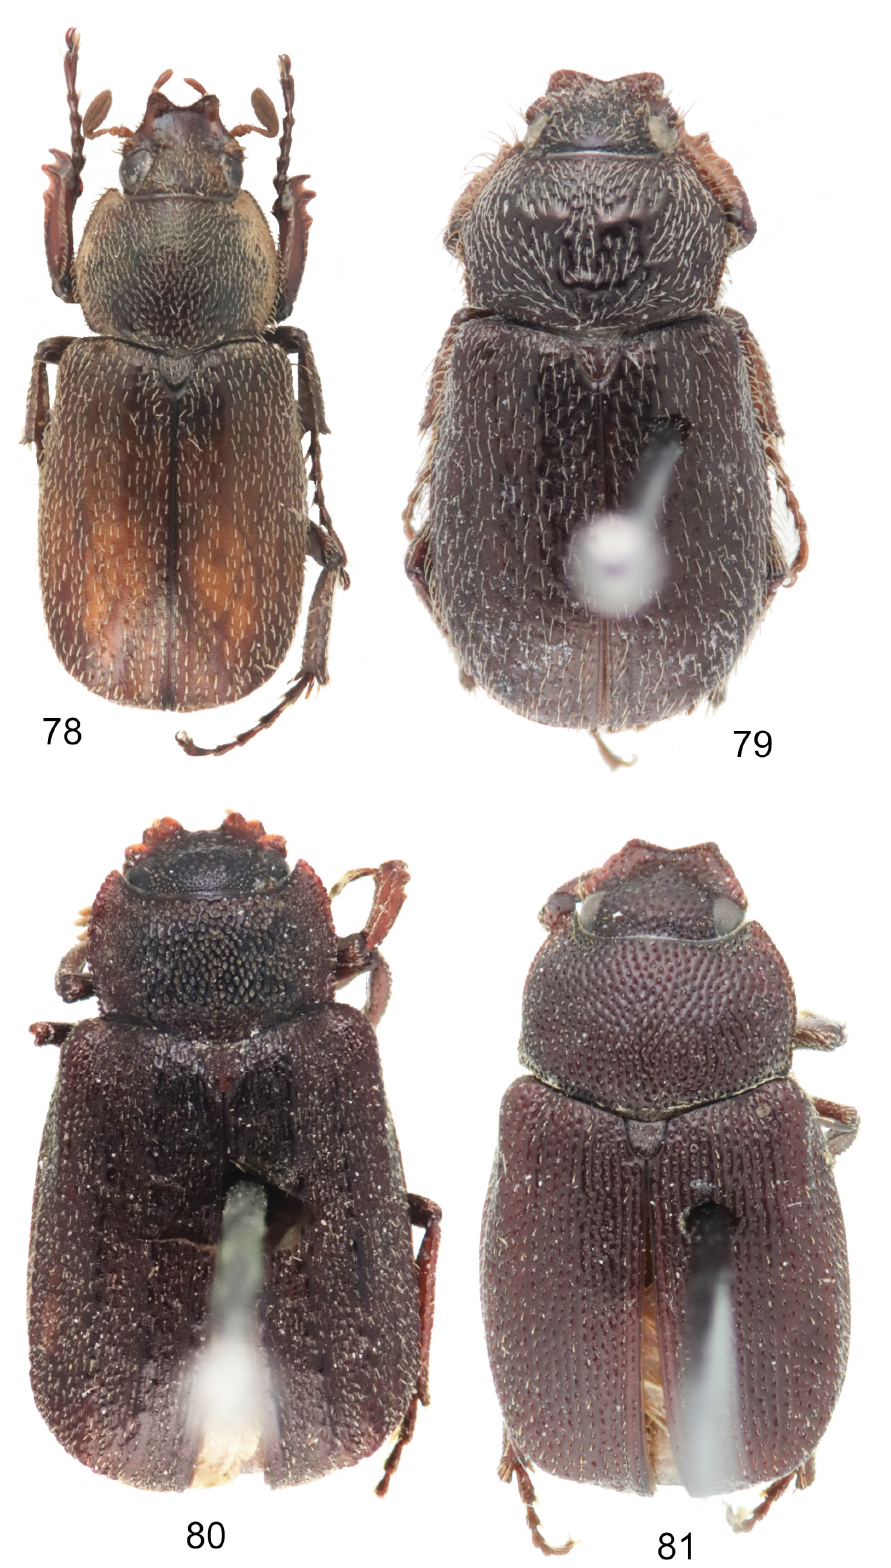
Figs 78–81. Papuan Maechidius Macleay, 1819, habitus, dorsal view. 78 . M. riedeli sp. nov., holotype, ♂ (SMNS). 79 . M. rugicollis Moser, 1920, lectotype, ♀ (ZMHB). 80 . M. seriegranosus Heller, 1914, lectotype, ♂ (SNSD). 81 . M. seriepunctatus Moser, 1920, lectotype, ♂ (ZMHB). Not to